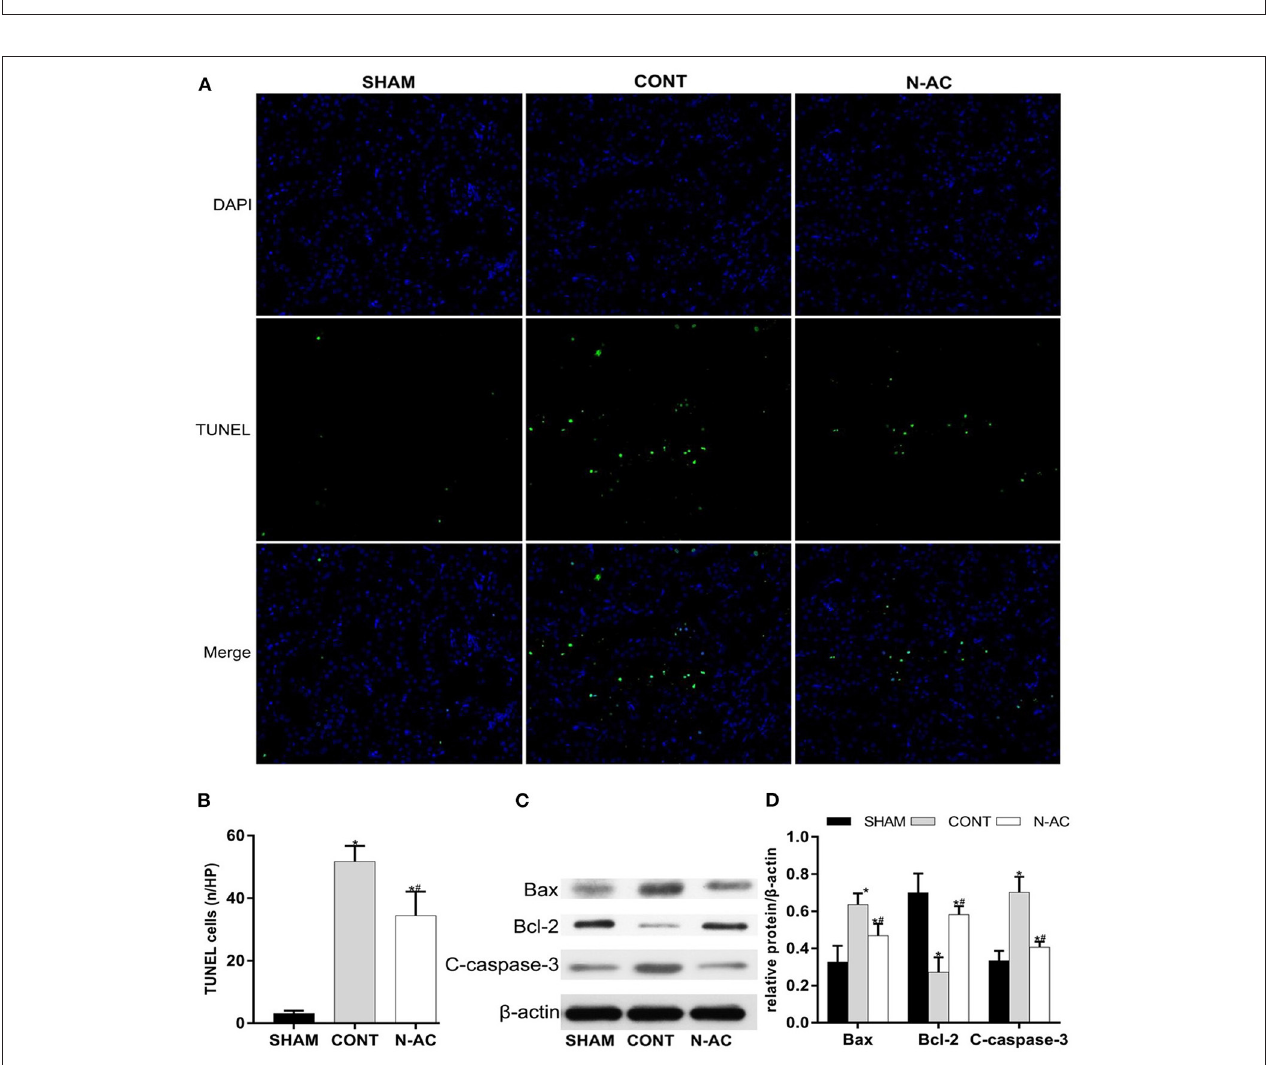
FIGURE 5 | N-AC inhibited renal cell apoptosis in the CPR models at 6h after ROSC. (A) TUNEL staining is used to detect the numbers of apoptotic cells in the kidney. (B) The rate of TUNEL-positive cells in three groups. (C) The protein levels of Bax, cleaved caspase-3 and Bcl-2 was evaluated via western blot. (D) The densitometric analysis of the expression of Bax, Bcl-2 and cleaved caspase-3. SHAM, sham group; CONT, control group; N-AC, N-AC group. Sham group, n = 5; Control group, n = 7; N-AC group, n = 7. Data are expressed as mean ± SD. * P < 0.01, vs. sham group; # P < 0.01, vs. control group. C-caspase-3, cleaved caspase-3.